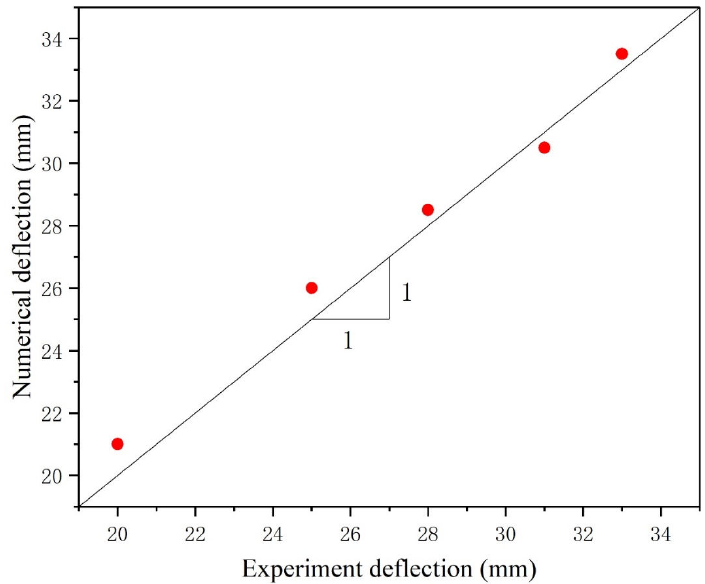
Figure 11. Comparison between the experimental and numerical predicted maximum central deflection of aluminum panel.